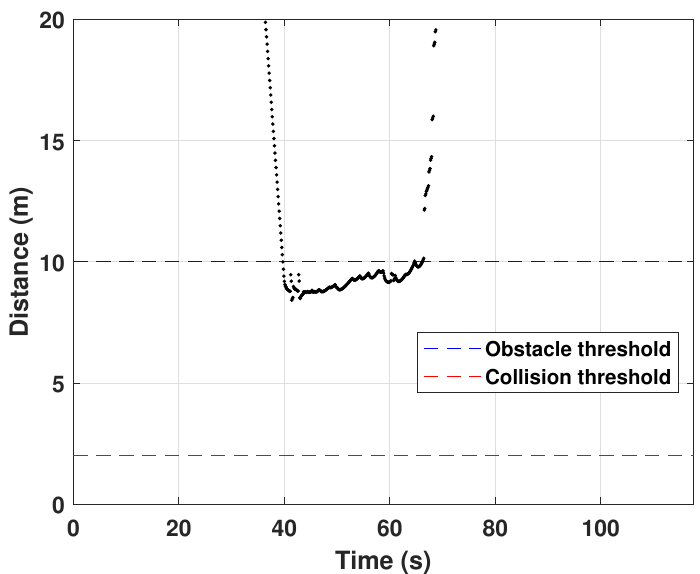
Figure 10. Case 1: Relative